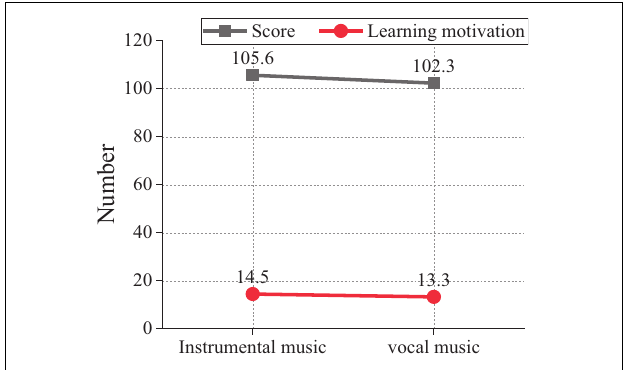
FIGURE 8 | Self-efficacy level of students learning different types of music.